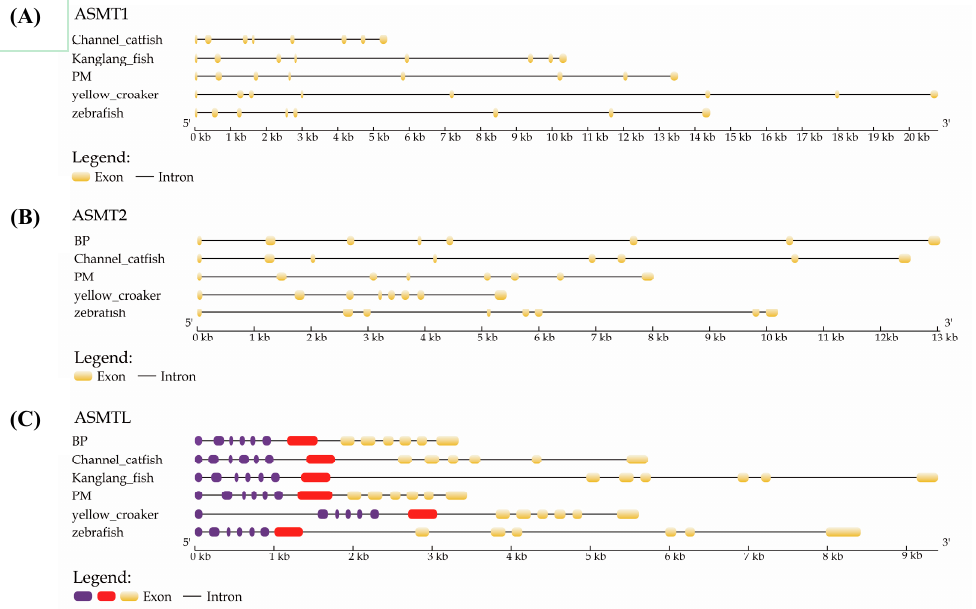
Figure 4. Exon-intron structures of ASMT1 ( A ), ASMT2 ( B ) and ASMTL ( C ) . Boxes in purple, red and yellow stand for the exons, while gray lines represent the introns. Note that the yellow boxes in ( C ) ASMTL are homologous to ASMT1 and ASMT2